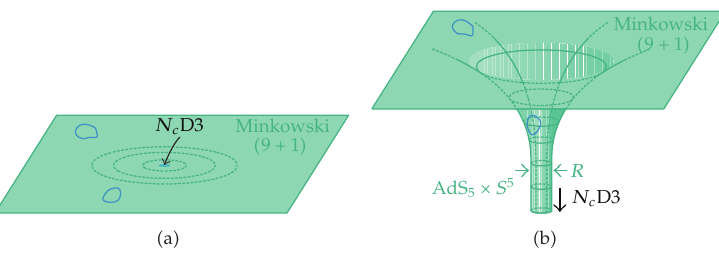
Figure 2: The two descriptions of the N c D3 configuration. (cid:2) a (cid:3) Flat spacetime for r (cid:8) R . N c D3 branes deform the